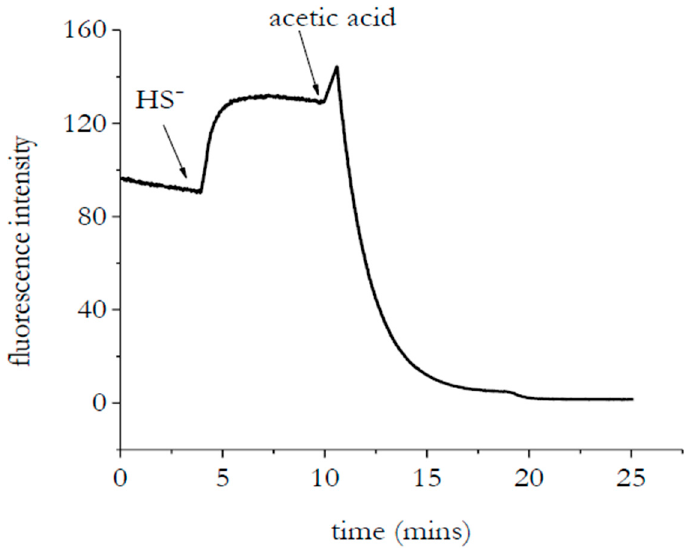
Figure 3. Emission spectrum of complex 1 ( λ ex = 481 nm; λ em = 550 nm), upon addition of 5 equiv of NaSH and upon addition of 10 equiv of acetic acid. [Complex 1 ] = 1 × 10 − 5 M; [NaSH] = 5 × 10 − 5 M. Spectrum was measured in DMSO.